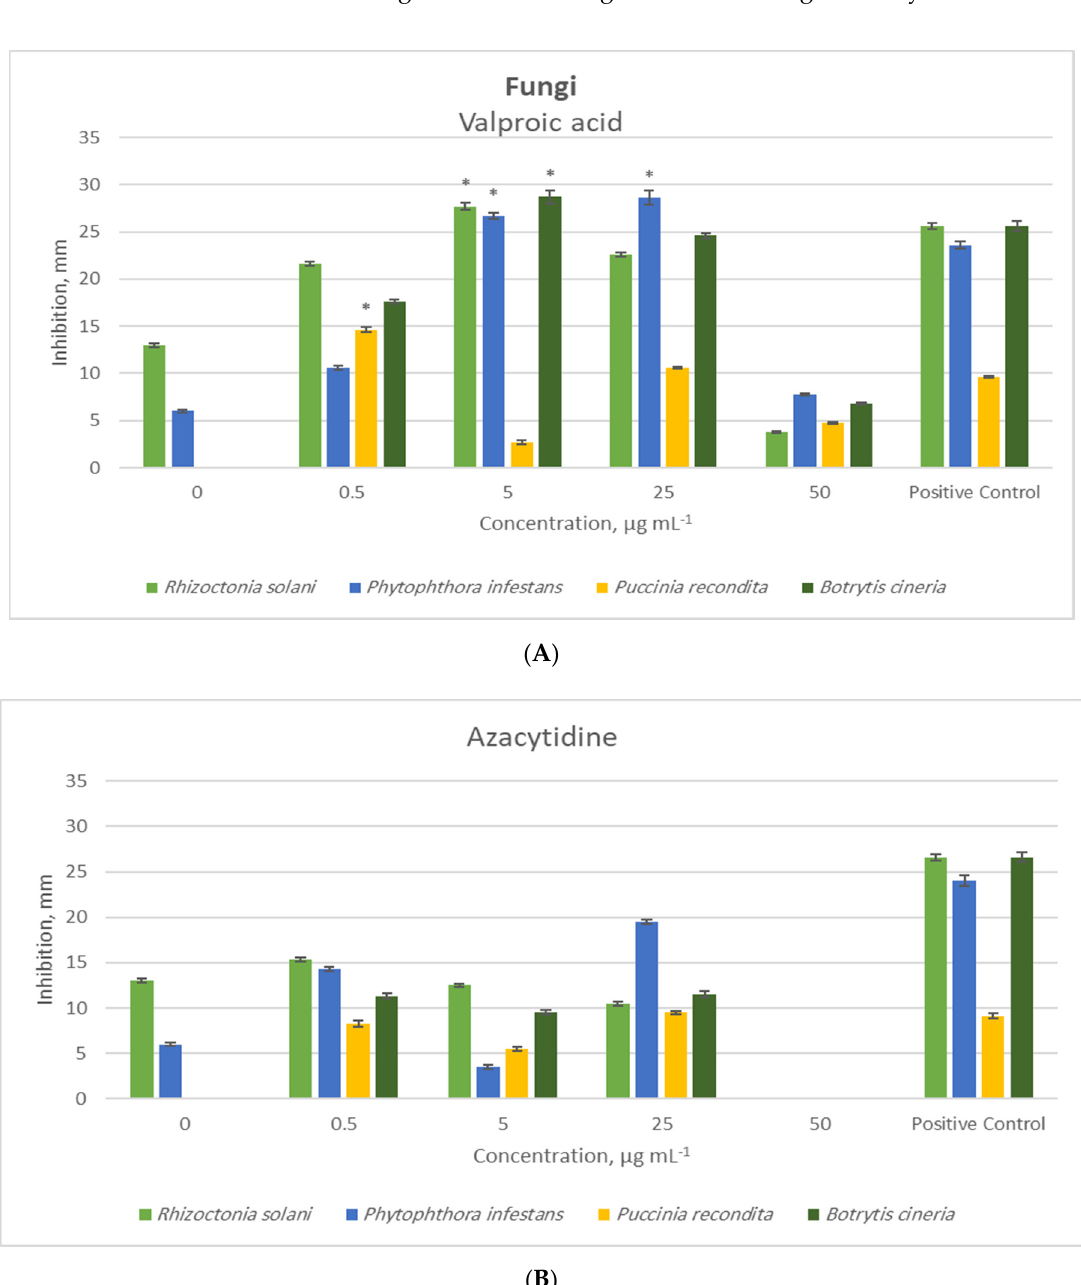
Figure 2. Antifungal activity (zone of inhibition, mean, and SD error bars, n = 3) of the crude extract of the endophytic fungus P. heveicola cultured with different concentrations of the epigenetic modifiers valproic acid ( A ) and 5-azacytidine ( B ), where 0 μ g/mL refers to the control treatment. The positive control contains gentamycin + fluconazole. * indicates significant difference ( t -test, p < 0.05) from the positive control.